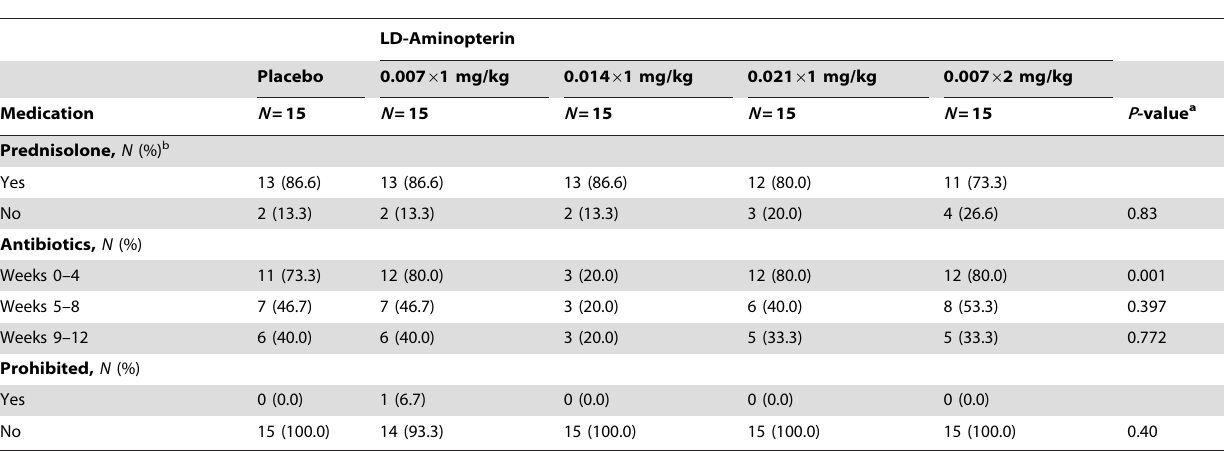
Table 2. Concomitant